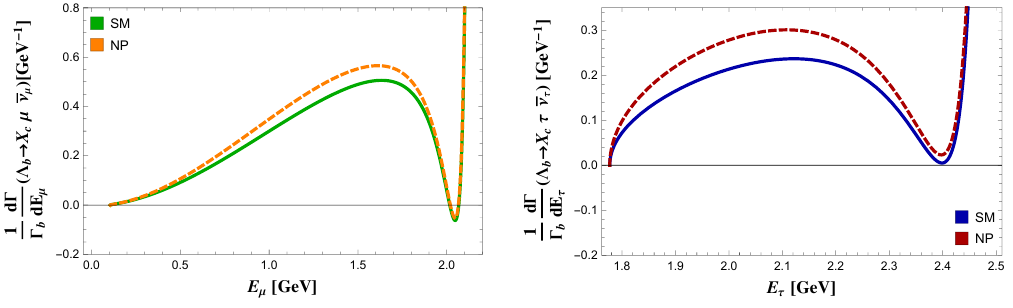
Figure 3 . Charged lepton energy spectrum for (cid:3) b ! X c ‘ (cid:22) (cid:23) ‘ , with ‘ = (cid:22) (left) and ‘ = (cid:28) (right). The solid line is the SM result, the dashed line the result for NP at the benchmark point.